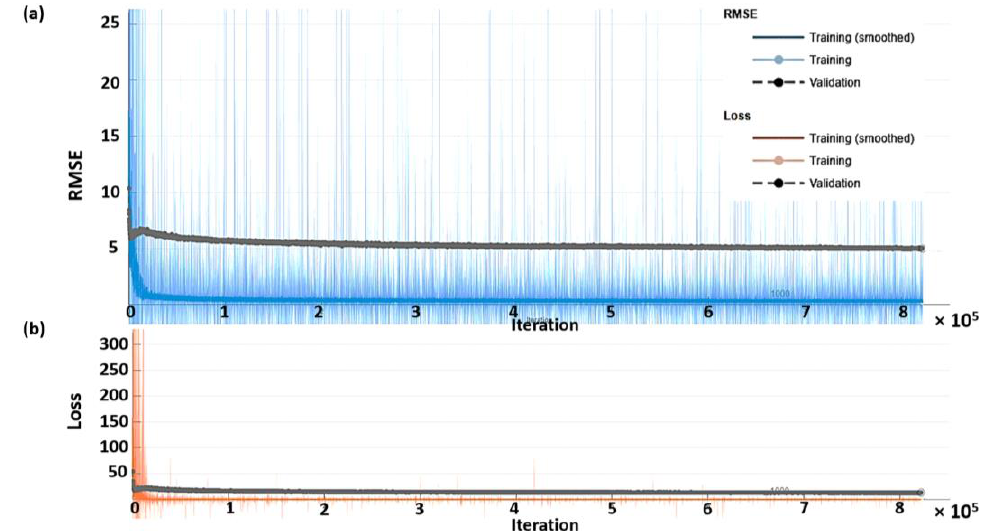
Figure 5. Shows the network training and validation for different iterations ranging from 0 to 82,500 epochs ( a ) RMSE in mmHg, and ( b ) loss; training RMSE is the blue curve, training loss is the red curve, and validation curves are shown in black.